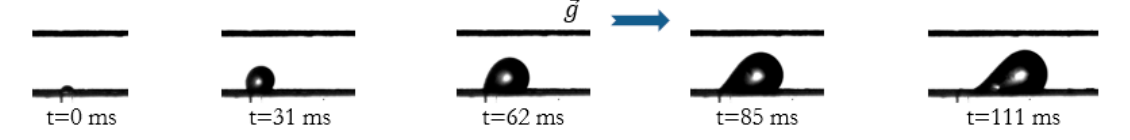
Figure 9. Emergence and shape evolution of a droplet (vertical channel).